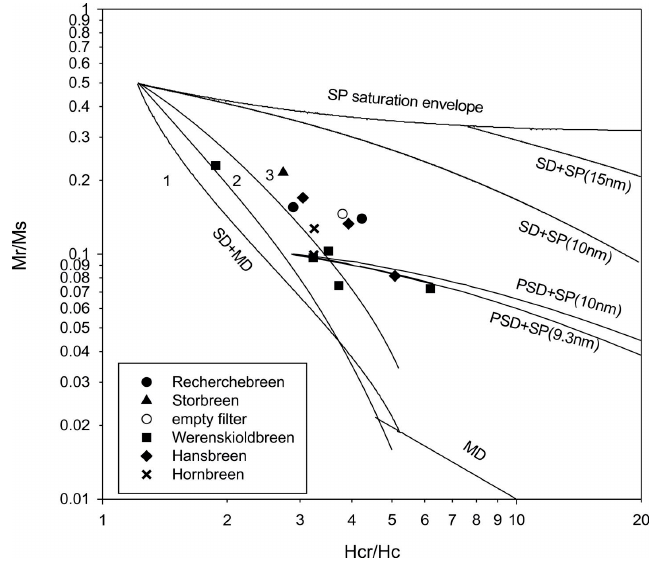
Figure 15. Day–Dunlop plot for empty filter and dust residues (Mr/Ms vs. Hcr/Hc ratios [40]). The theoretical mixture lines for SP, SD–SP, PSD–SP and SD–MD magnetite after Reference [40] are drawn.